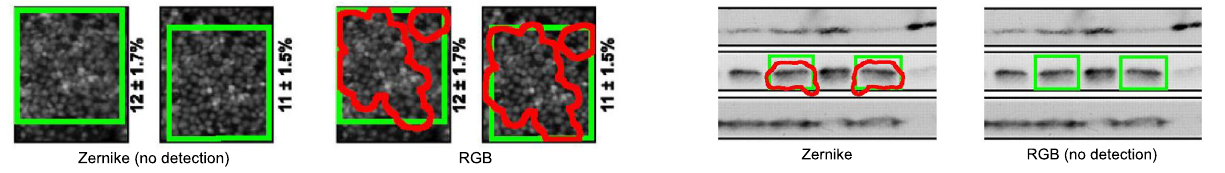
Figure 10. Comparison of copy-move detection results using either Zernike or RGB features. Ground-truth annotation is represented by green boxes, while the red regions correspond to the cloned content automatically detected by SILA. In ( a ), detection over cell images. In ( b ), detection over western blots. While Zernike features did not work for cell images, RGB features did not work for western blots. For this reason, we propose a fusion of such techniques within SILA. All original panels within this figure belong to papers published as Creative Commons content, under DOI ( a ) https:// doi. org/ 10. 1074/ jbc. M110. 172767 and ( b ) https:// doi. org/ 10. 1074/ jbc. M8035 47200. Here, they were cropped, enlarged, and annotated over, in either green or red, to convey the findings of panels, the multiple masks are combined at the end of the process (see Fig. 9, Clone Mask Result) to generate the final image clone mask.